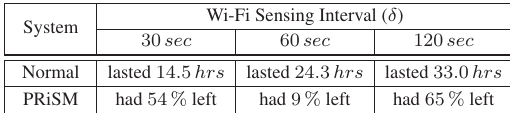
Table 5: Nexus One practical energy